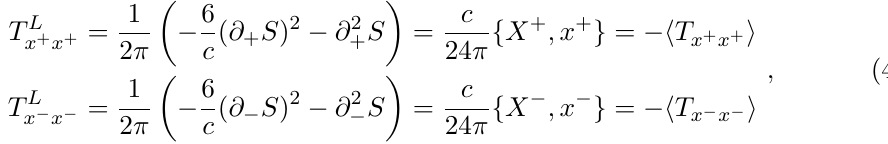
Figure 2 . Interval [ P , boundary x = 0] (in blue) on a constant time slice of a bCFT 2 in vacuum state 0 . It is speci(cid:12)ed by the location of the point P in CFT lightcone coordinates ( x + j i X kinematic space construction involves 1) promoting the x = 0 boundary of the CFT to spacelike in(cid:12)nity of kinematic space, 2) identifying x + and x (cid:0) with kinematic space lightcone coordinates, and 3) using the one-interval entanglement formula to de(cid:12)ne a hyperbolic metric on kinematic space through equation (4.3). The yellow triangle is a sketch of the emergent AdS 2 kinematic space K @ , superimposed here on the picture of the bCFT background. Note that the kinematic space lightcone coordinates are just given by the bCFT lightcone coordinates, which is di(cid:11)erent from the situation in (cid:12)gure 1 for a CFT without